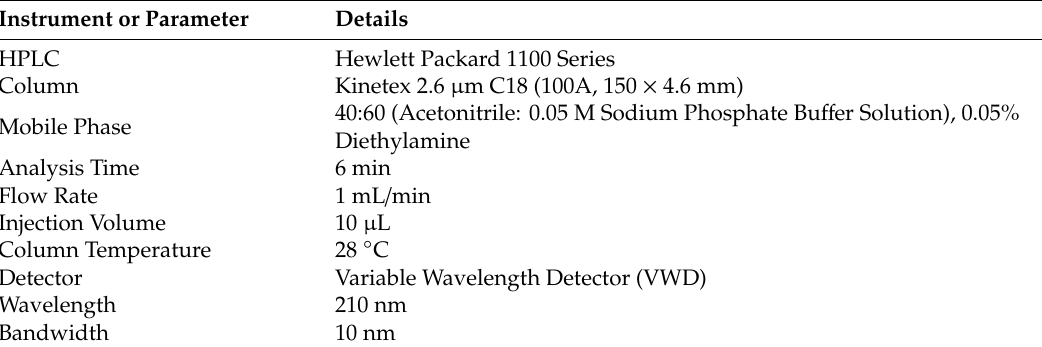
Table 2. HPLC specifications and run